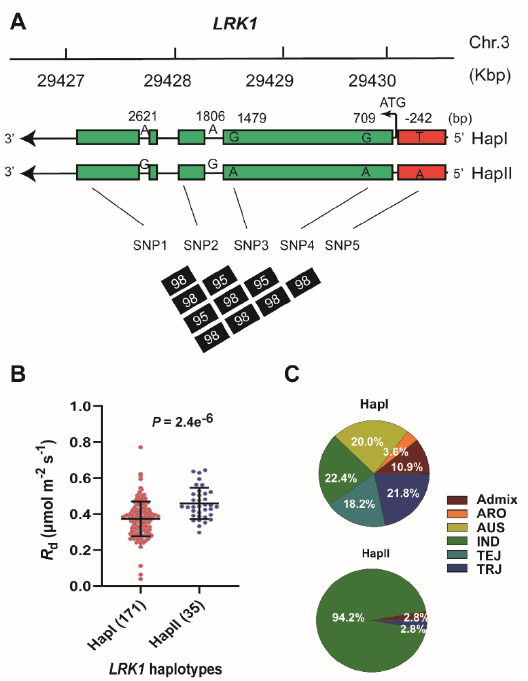
Figure 4. Haplotype analysis of LRK1 . ( A ) Pair-wise LD between SNP markers on the promoter and coding region of LRK1 on Chr. 3. The LD was indicated as D’ values via Haploview software. Two haplotypes (HapI and HapII) were shown harboring five alternative SNPs at different position. The five SNPs from SNP1 to SNP5 are 3m29427828, 3m29428645, 3m29428974, 3m29429743, and 3m29430694 at + 2621 bp, + 1806 bp, + 1479 bp, + 709 bp, and − 242 bp, respectively. SNP1 and SNP2 are located in intron, while SNP 3 and SNP4 are at exon of LRK1 gene body; however, SNP5 is on promoter region. ( B ) Comparison on R d between HapI and HapII with the accessions number for each haplotype are indicated in brackets. A t -test was performed to estimate the P- value between the two haplotypes. ( C ) Pie-charts of two haplotypes. The percentage of each subpopulation relative to the overall population number was also indicated for each haplotype. Subpopulation includes admixture (admix), aromatic (ARO), aus (AUS), indica (IND), temperate japonica (TEJ), and tropical japonica